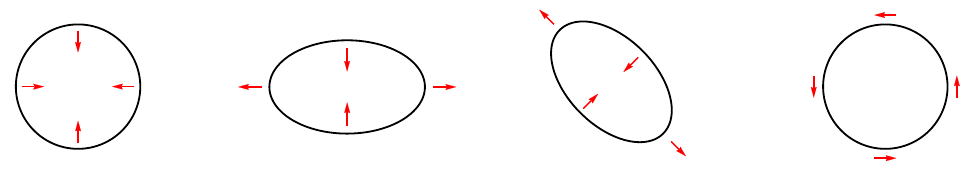
Figure 1 . Illustration of the e(cid:11)ect of the optical tensors on the Tissot circle. From left to right, the (cid:12)gures show the expansion ^ (cid:18) , + oriented shear ^ (cid:27) + , (cid:2) oriented shear ^ (cid:27) (cid:2) , and the twist ^ !